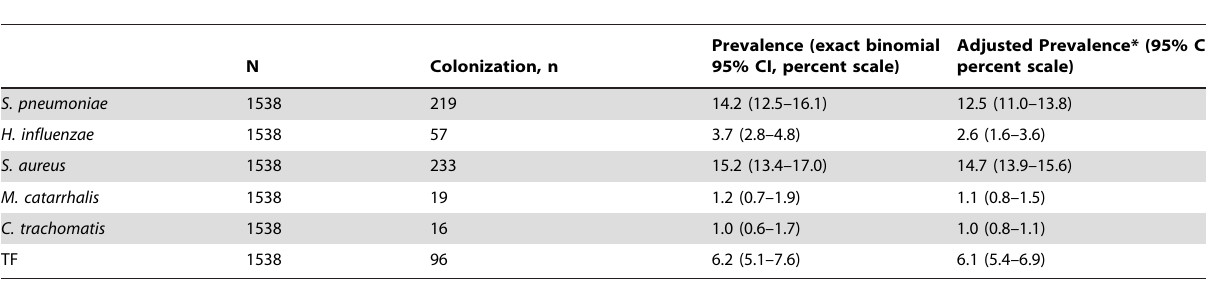
Table 1. Prevalence of ocular bacterial colonization, C. trachomatis infection and TF.